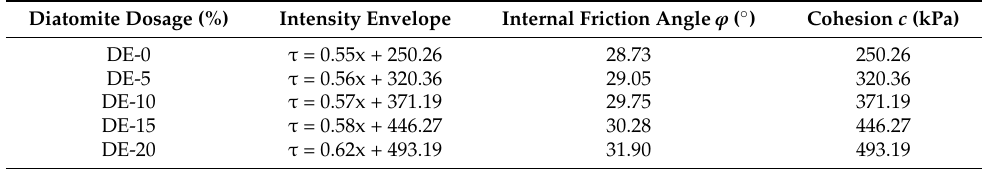
Table 6. Shear strength parameters of coastal cement soil with different diatomite contents.